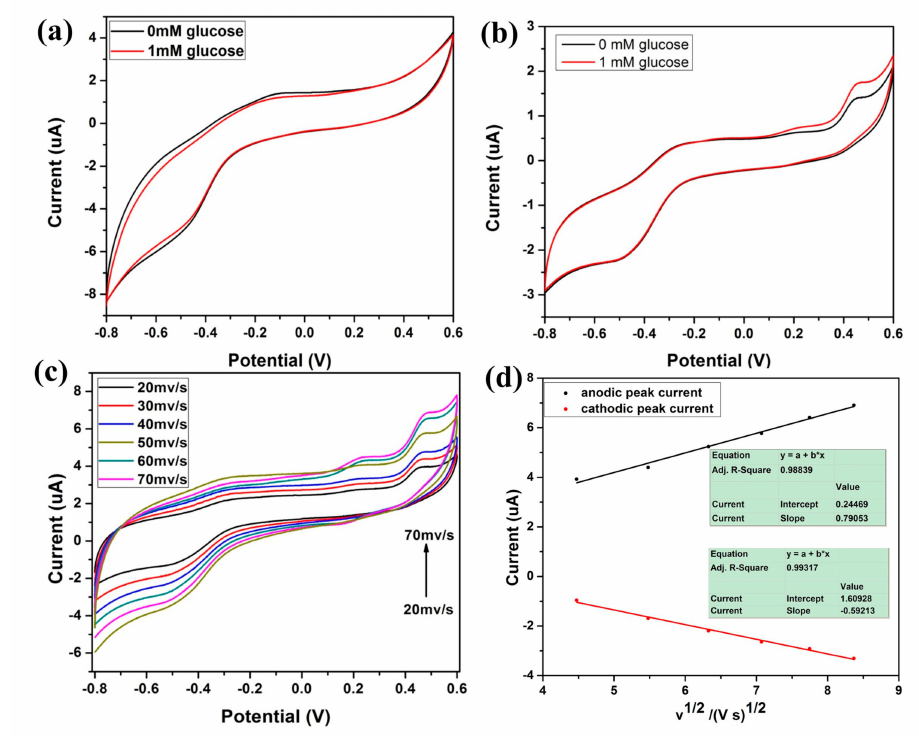
Figure 5. CVs of ( a ) CHIT / CNT and ( b ) Fc-CHIT / CNT@Cu electrodes in 0.1M NaOH electrolyte without glucose and with 1 mM glucose. ( c ) CVs of the Fc-CHIT / CNT@Cu electrode in 0.1M NaOH electrolyte at scan rates of 20, 30, 40, 50, 60 and 70 mV / s. ( d ) Plots of anodic and cathodic peak currents versus scan rates (v 1 / 2